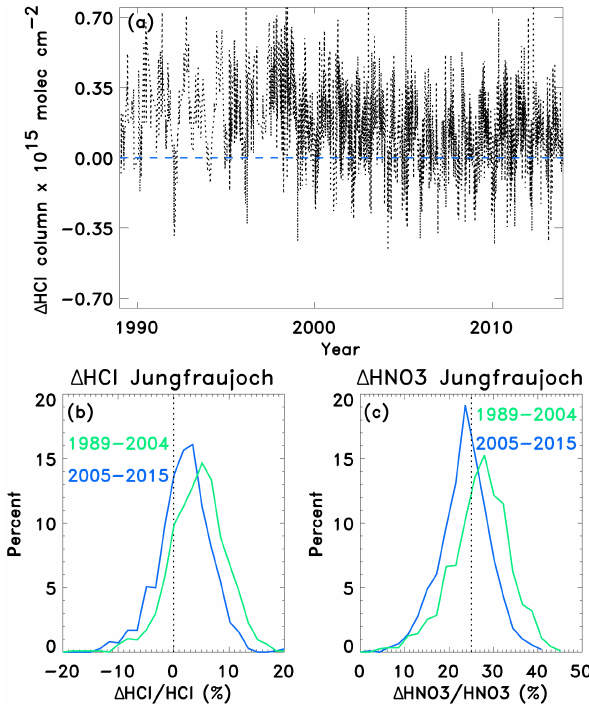
Figure 6. (a) Time series of the differences between observed and simulated HCl columns at Jungfraujoch. Histogram of the percent- age differences for 1989–2004 (green) and 2005–2015 (blue) (b) for HCl and (c) HNO 3